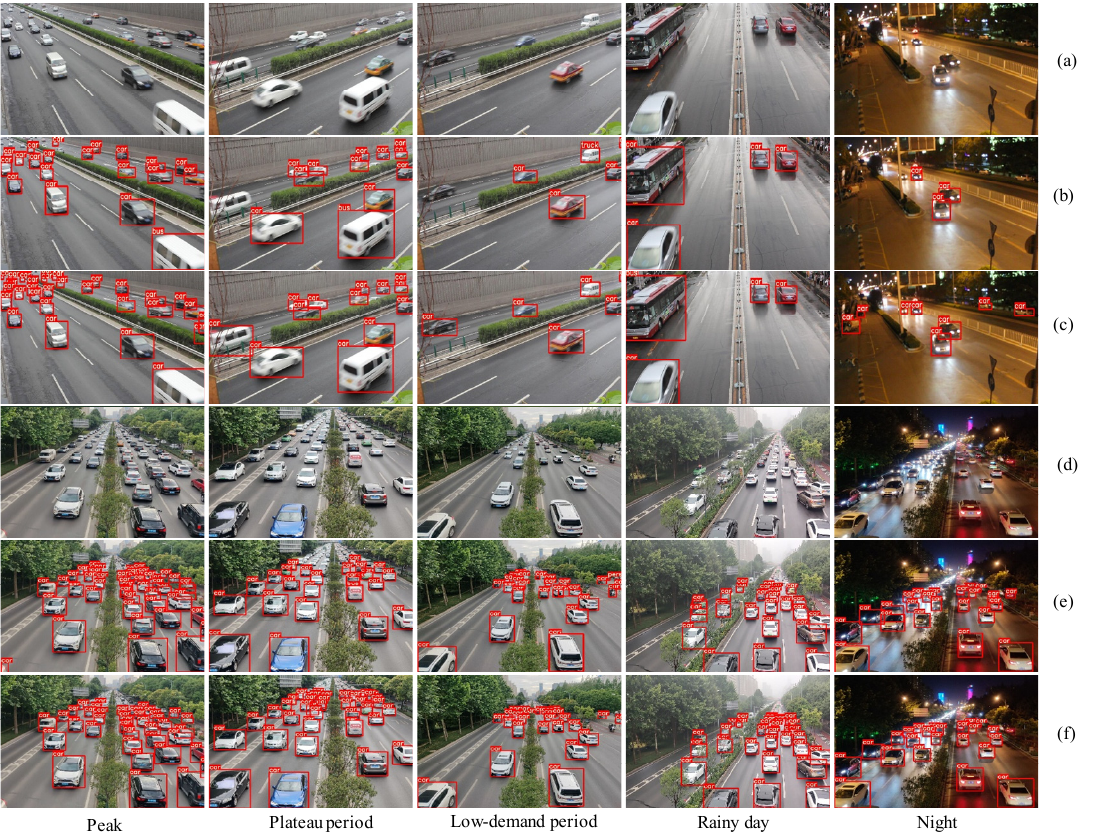
Figure 11. Comparison of original model results ( b , e ) and optimized model results ( c , f ) for two datasets: ( a , d ).